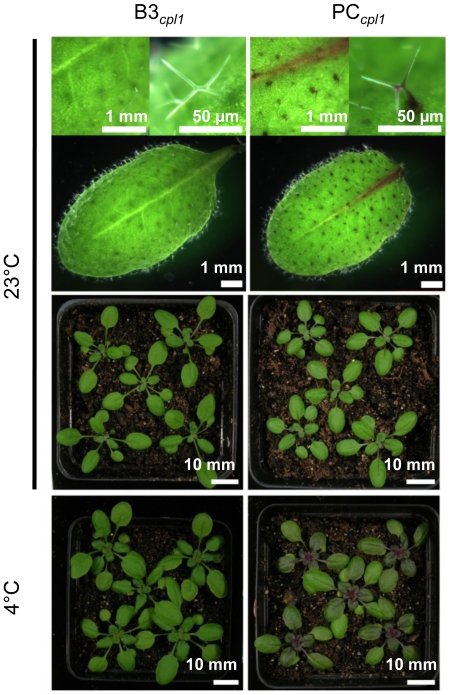
Photographs of leaves of homozygous transgenic B3cpl1 and in PCcpl1 plants under normal growth condition for 3 weeks (23°C) and after cold treatment (4°C) for additional 3 weeks.